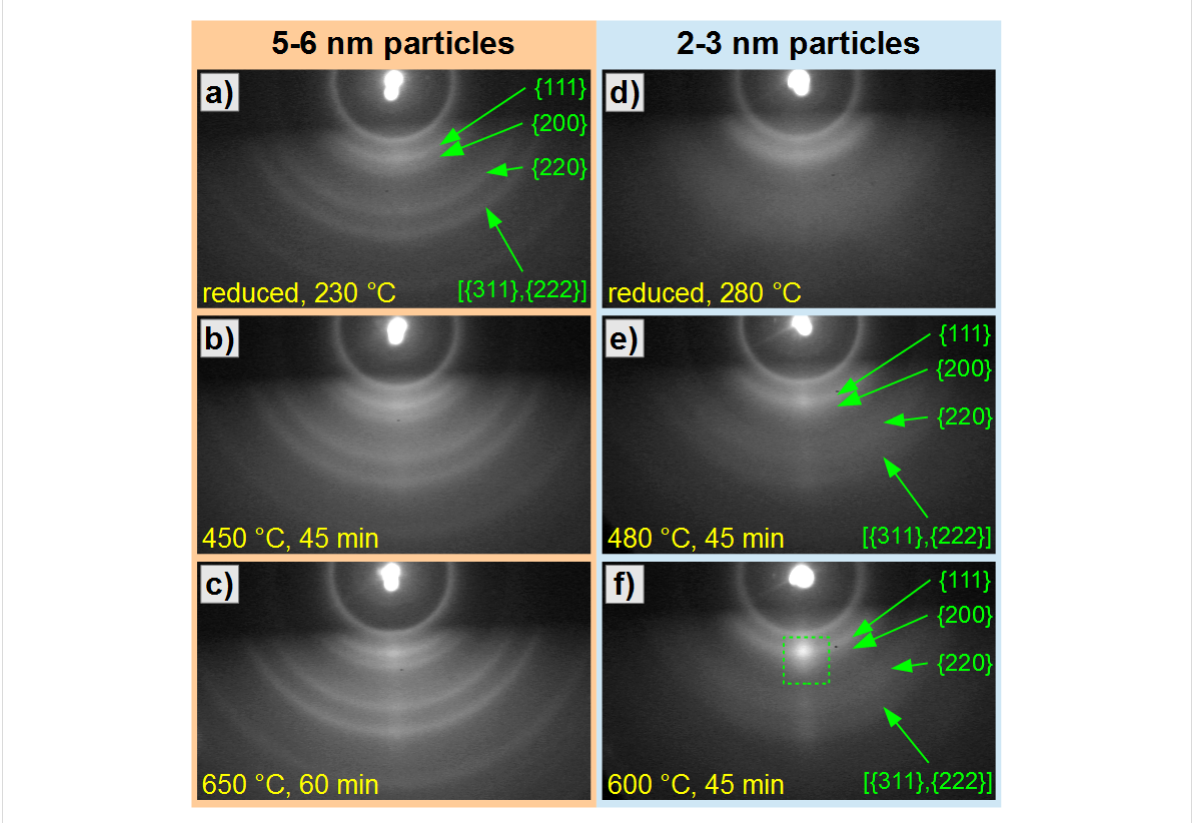
Figure 8: (a–c) RHEED patterns of large (5–6 nm) FePt nanoparticles prepared on MgO(001), recorded with an electron beam energy of 25 keV after different annealing steps. The patterns show Debye–Scherrer rings with a homogeneous intensity along the ring periphery indicating a random orien- tation of the nanoparticles. By annealing at 650 °C the sharpness of the rings is slightly enhanced. (d–f) RHEED patterns of small (2–3 nm) FePt nanoparticles prepared on MgO(001) after several annealing steps. Broad Debye–Scherrer rings appear due to the small particle size. (d) After reduc-